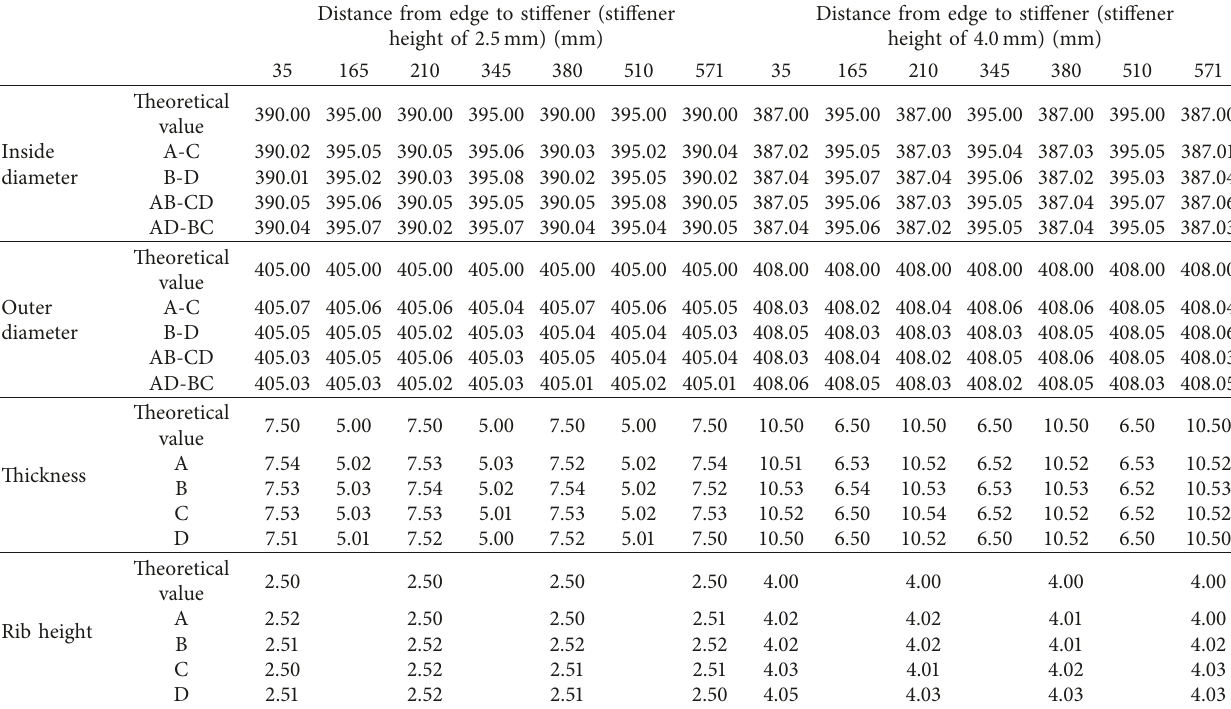
Table 11: Measured dimensions of samples with rib heights of 2.5mm 4.0mm. Distance from edge to stiffener